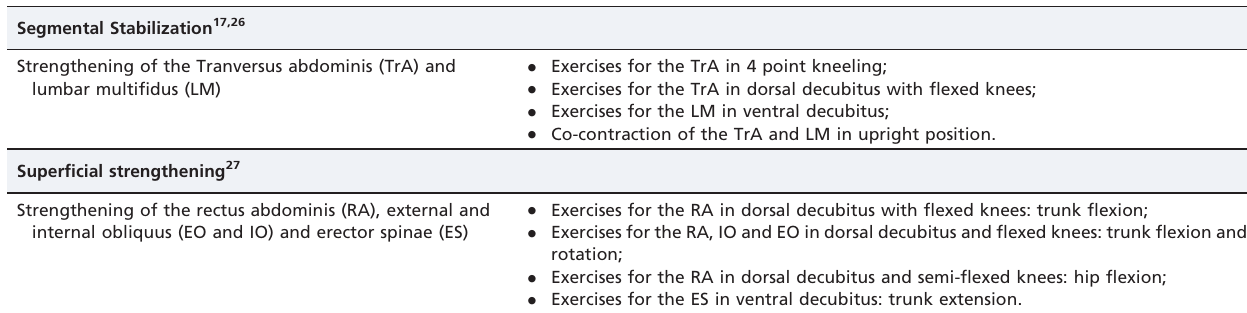
Table 1 - Treatment protocol in the segmental stabilization and superficial strengthening